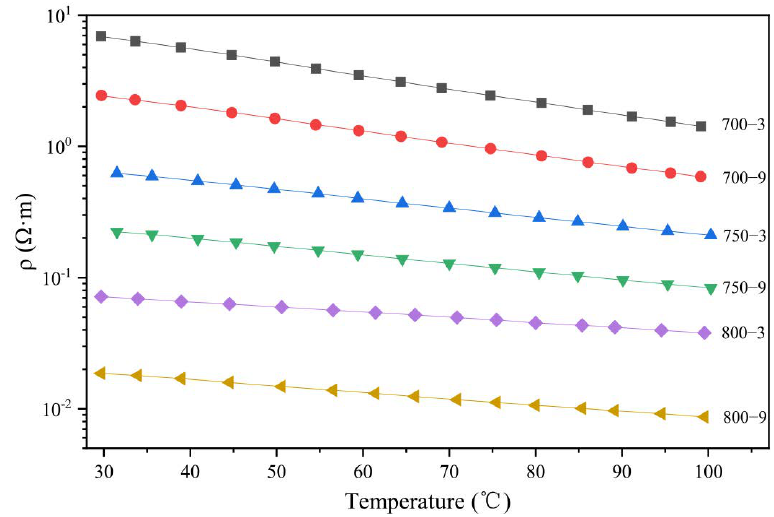
Figure 3. Temperature sensitivity of the